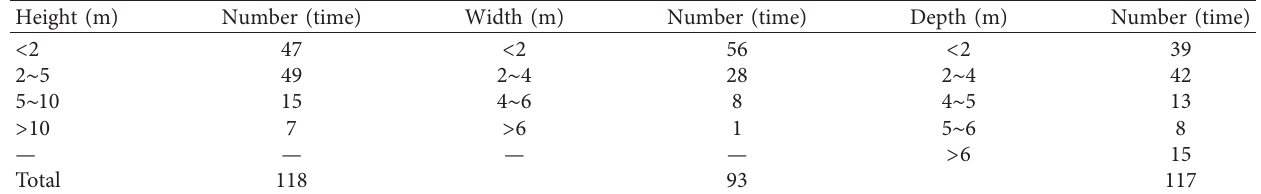
Table 1: Geometric parameters statistical data of more than 100 caverns that occurred during tunnel excavating in Chongqing district [22]. Height (m)